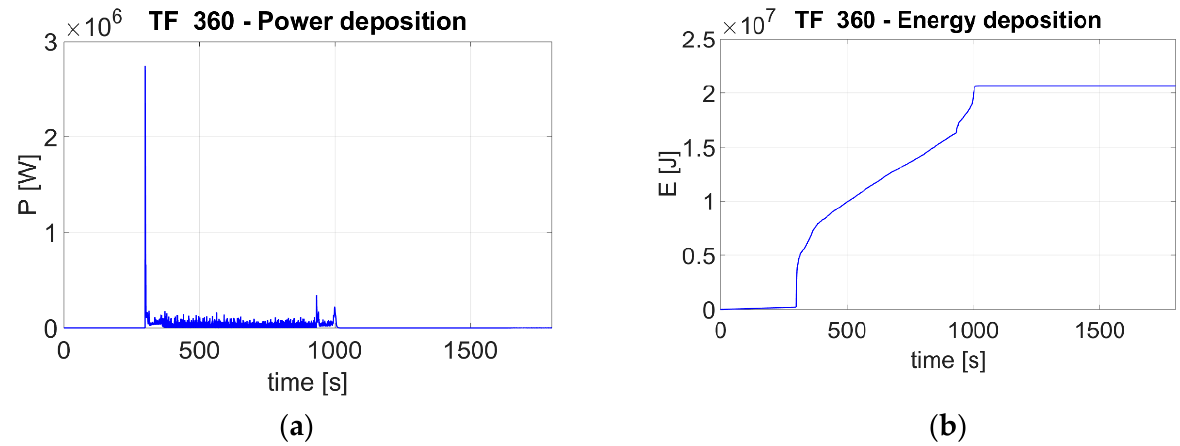
Figure 12. Testcase#1: The power ( a ) and the energy dissipation ( b ) in the TF coil case system.